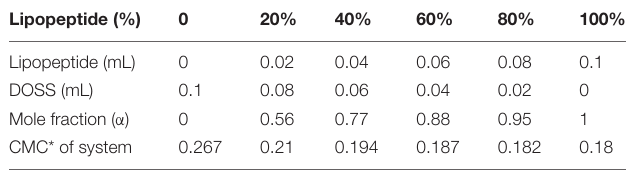
TABLE 4 | Critical micelle concentrations (CMC) of lipopeptide-DOSS binary mixture.